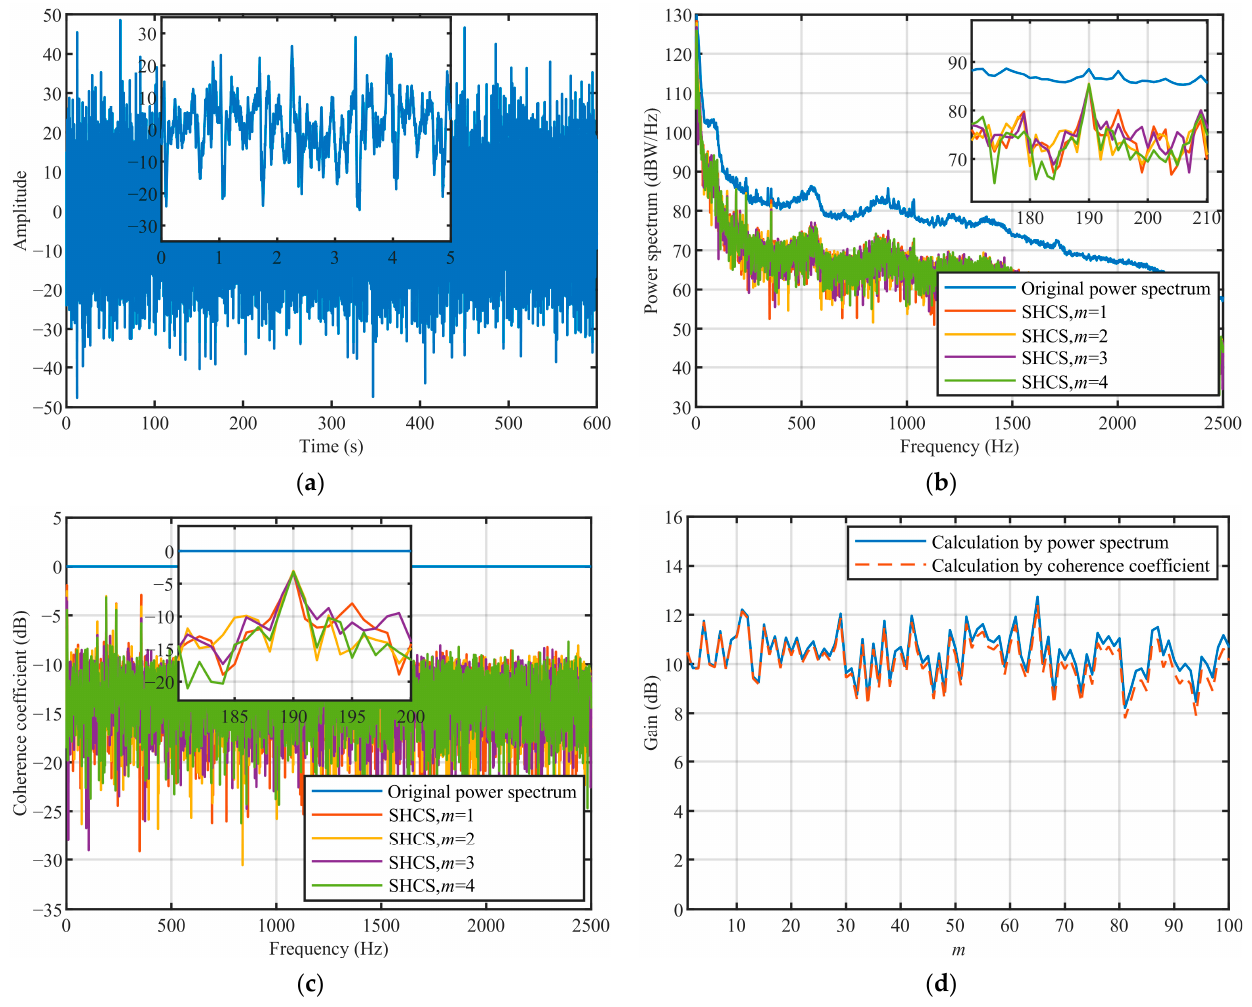
Figure 10. SHCS processing results at 100 km with different values of m : ( a ) time domain waveform; ( b ) power-spectrum estimation; ( c ) coherence coefficient; ( d ) gain.